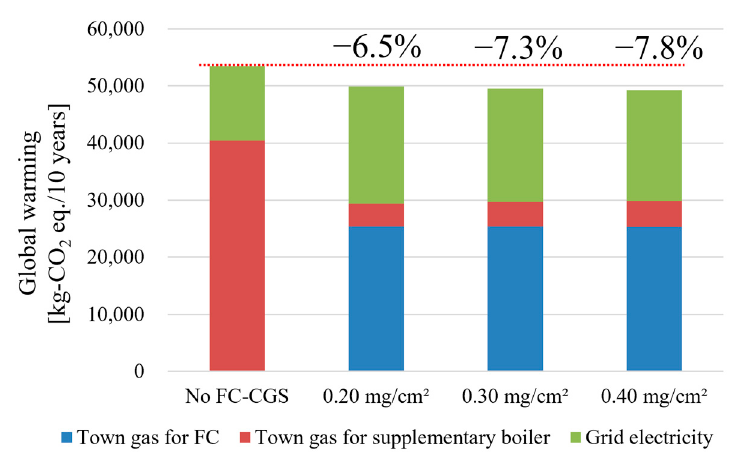
Figure 14. Relationship between GWP and Pt loading amount .